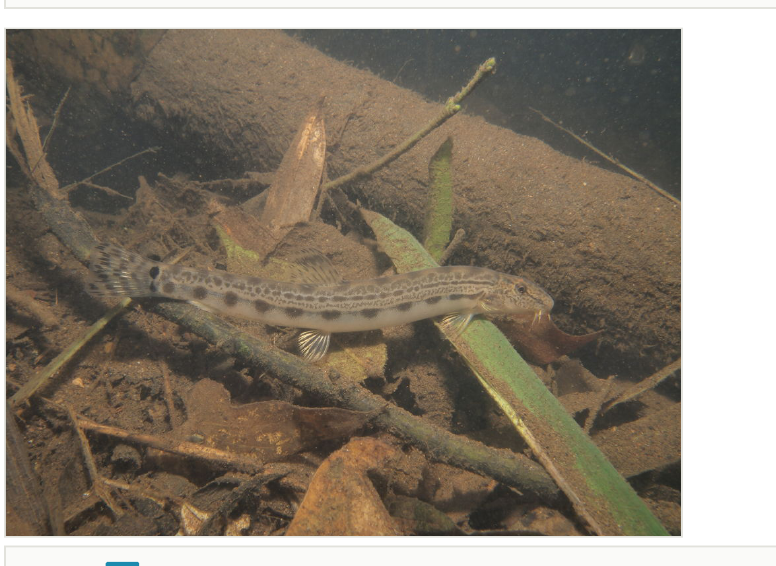
Figure 2. A photo image of Cobitis sakahoko in the wild, under cloudy water by volcanic ash of Mt.